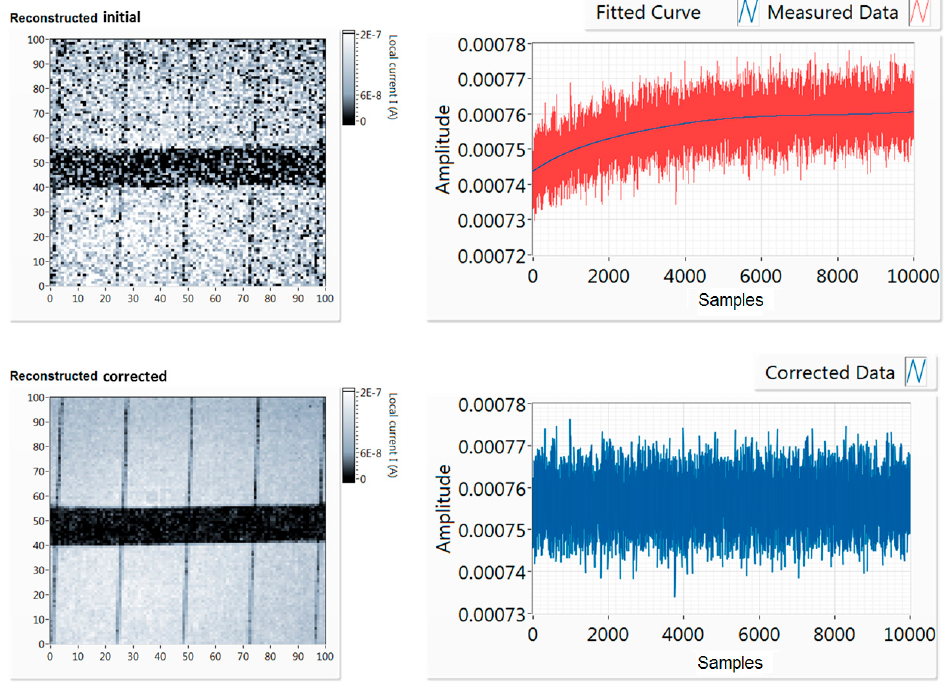
Figure 8. A case of drift correction of sampled data, using 80% pixels “on” patterns. On the top row, the uncorrected map and sampled data, at the bottom, the corrected map and data.